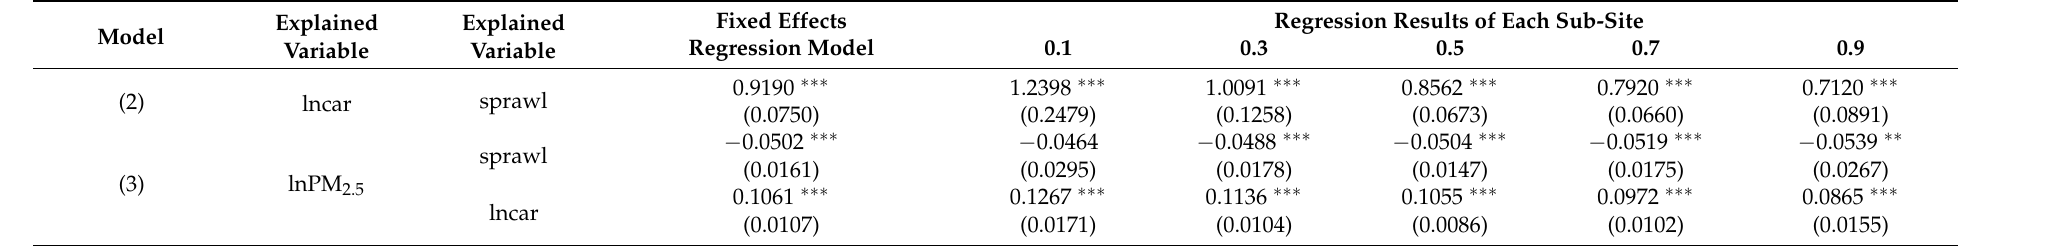
Table 3. Panel quantile regression results.